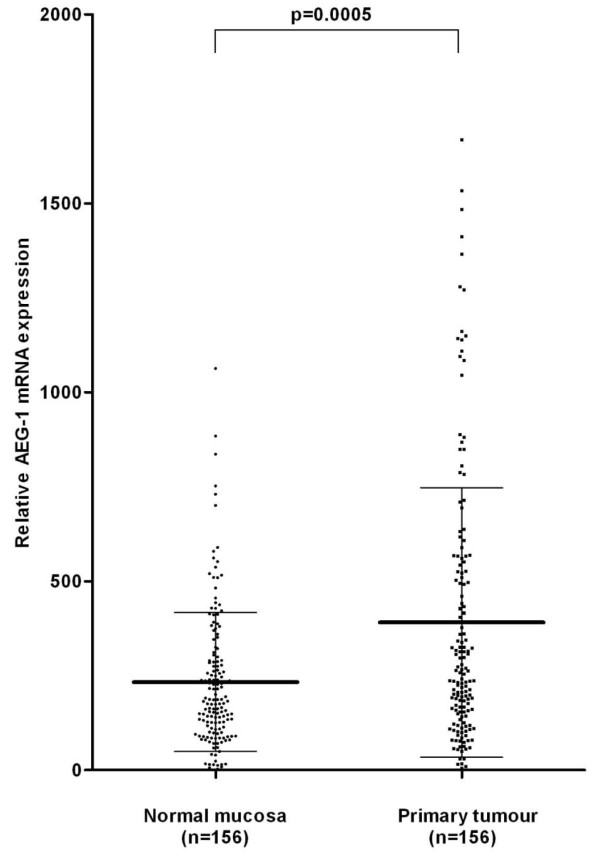
AEG-1 mRNA expression in normal colorectal mucosa and the corresponding primary colorectal cancer. The mean value of AEG-1 mRNA expression measured by qPCR increased significantly from normal mucosa (214.98 ± 156.39) to the primary tumour (371.56 ± 348.37, p = 0.0005). Bold line and whiskers represent mean ± standard deviation.